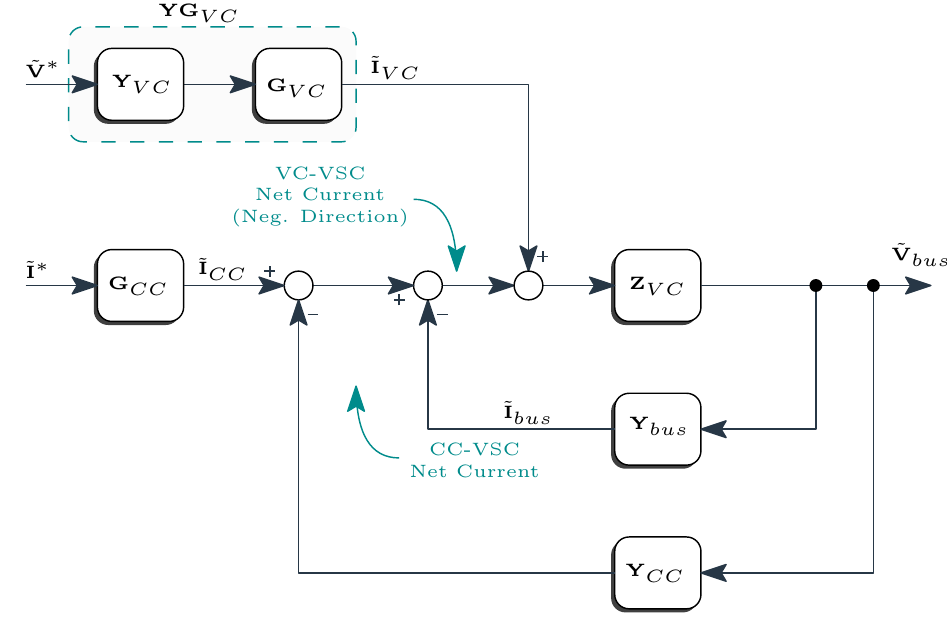
Figure 8. Block diagram representing the proposed simulation